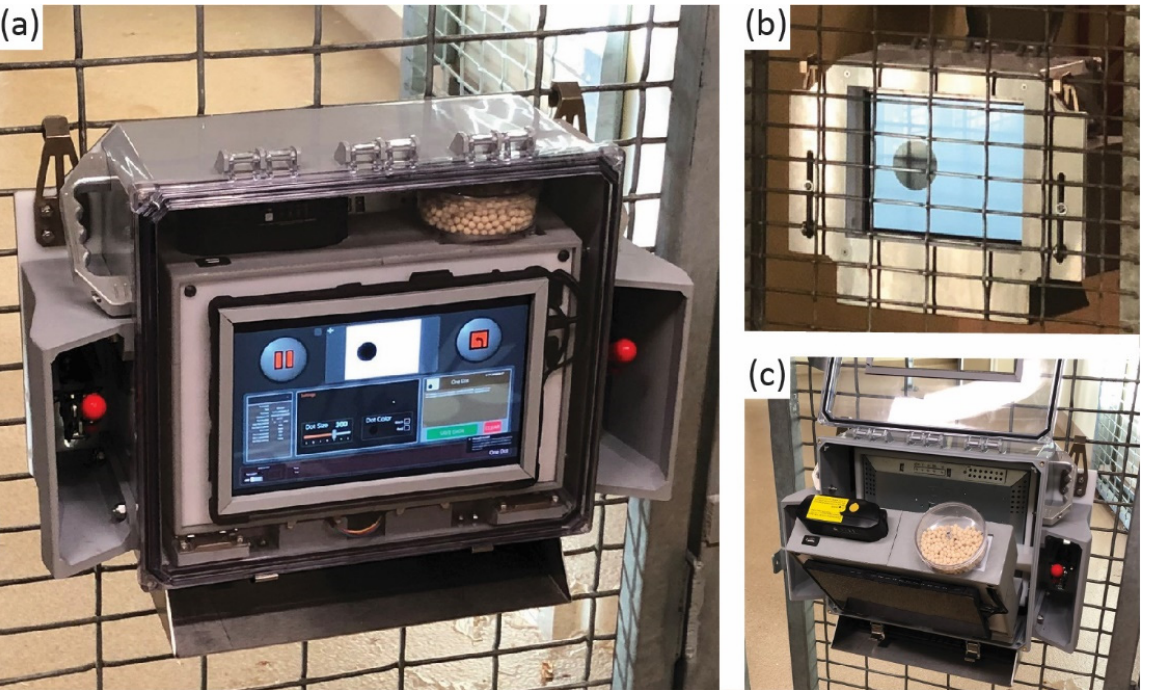
Figure 1. ( a ) View of the Apex machine from behind where the human operator is situated. ( b ) View of the front, where the primate is situated. ( c ) View of the Apex machine with the back cover open and the core box extended outward.